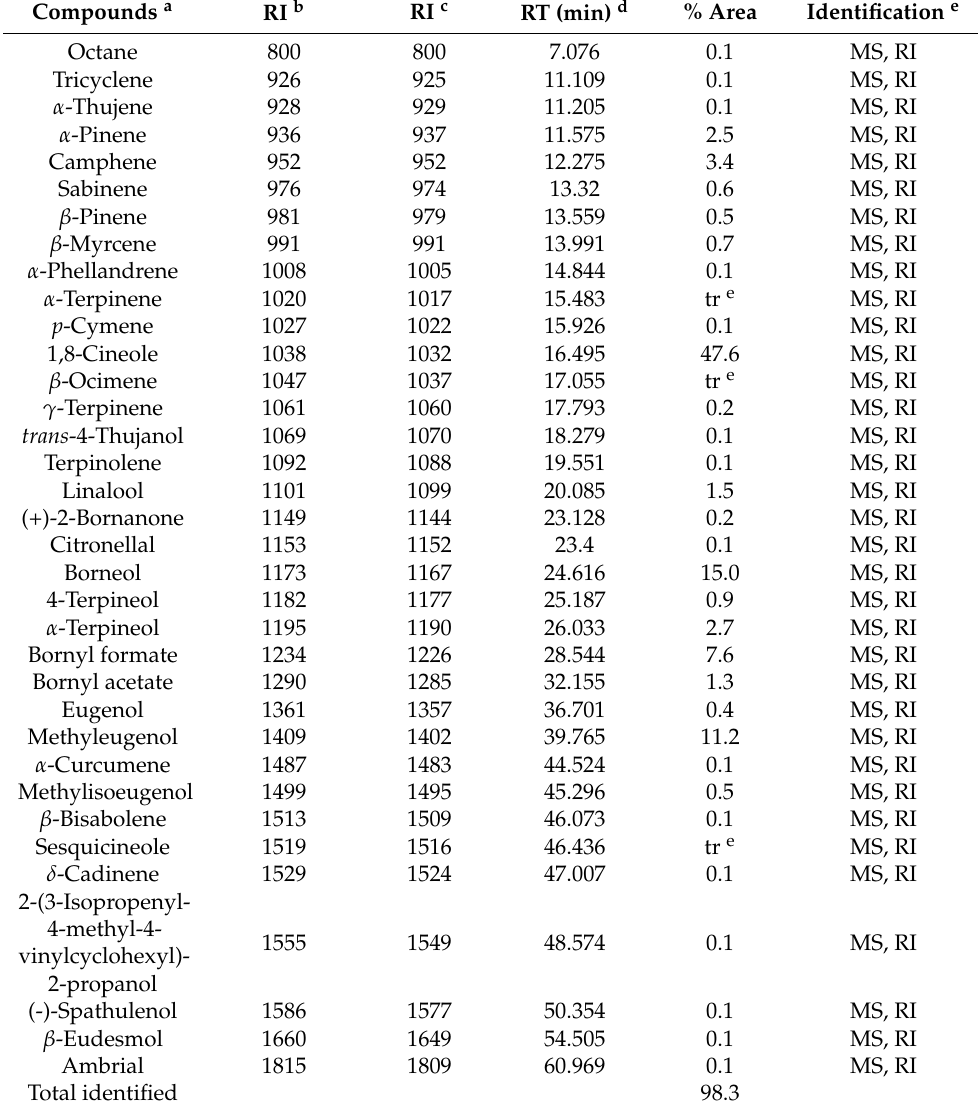
Table 1. Chemical composition of the essential oil from R. beesianus